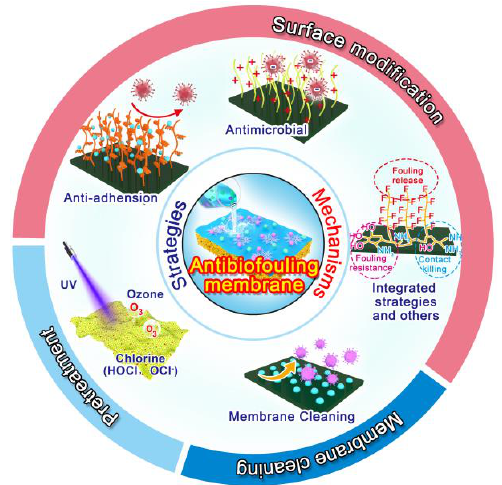
Figure 1. Schematic diagram of various strategies of biofouling control that are applied to water- treated polymeric membranes.